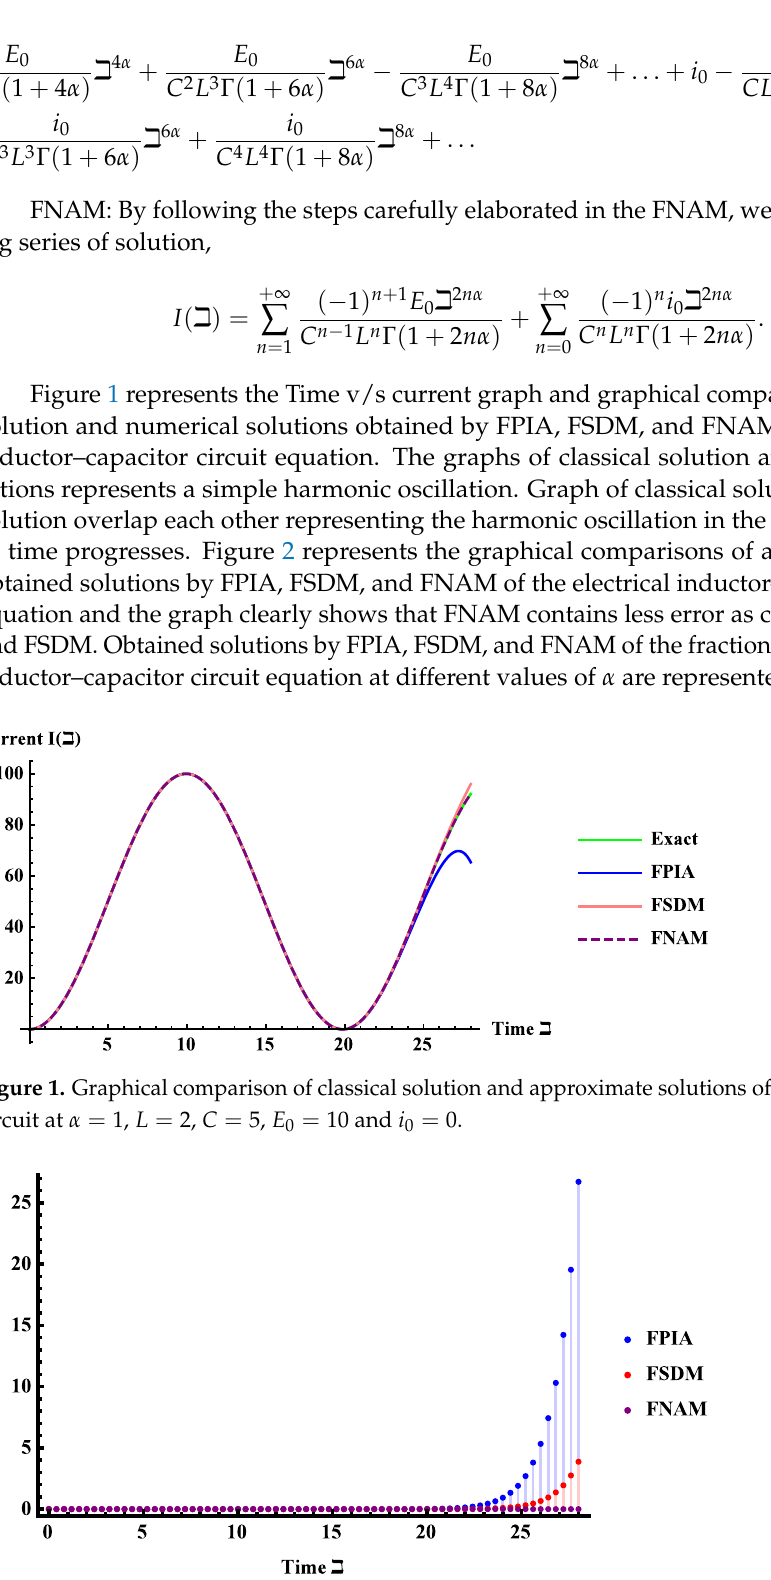
Figure 2. Graphical comparisons of Absolute Errors (AE) of obtained solutions by FPIA, FSDM, and